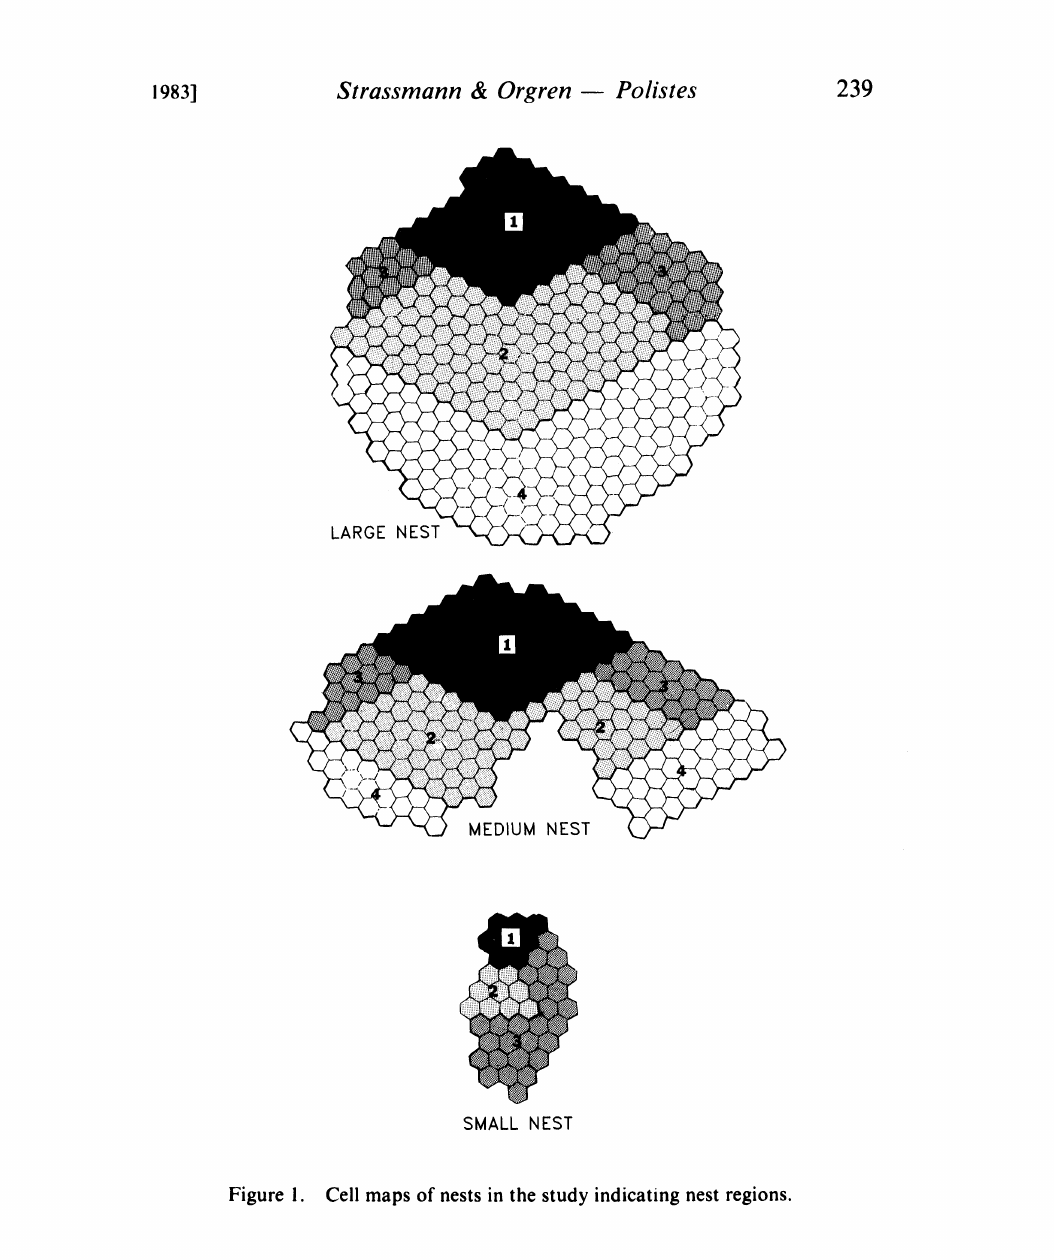
Figure 1. Cell maps of nests in the study indicating nest